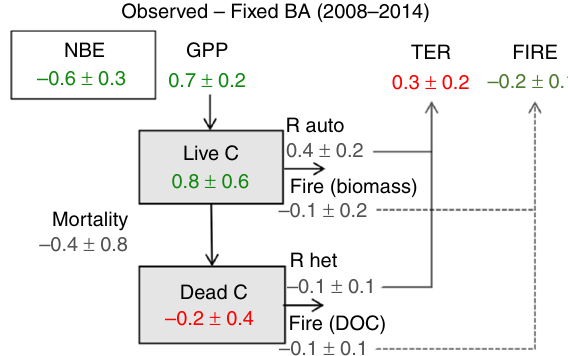
Fig. 4 Differences in the major carbon fl uxes and pools between the two scenarios. The 2008 – 2014 average differences between the Observed BA and Fixed BA scenarios are shown (Units: PgC per year). Increases in the land sink is denoted in green and decreases in the land sink is denoted in red. NEE = TER − GPP and NBE = NEE + FIRE; negative NBE values represent net fl uxes from the atmosphere to the land. Uncertainties are estimated by MCMC simulations.